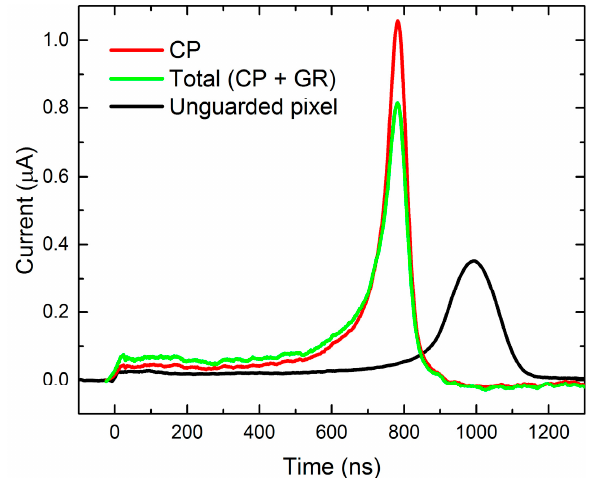
Figure 7. Current waveforms measured on different electrodes at S 33 illumination with respective values of collected charge and transit time shown in the inset.